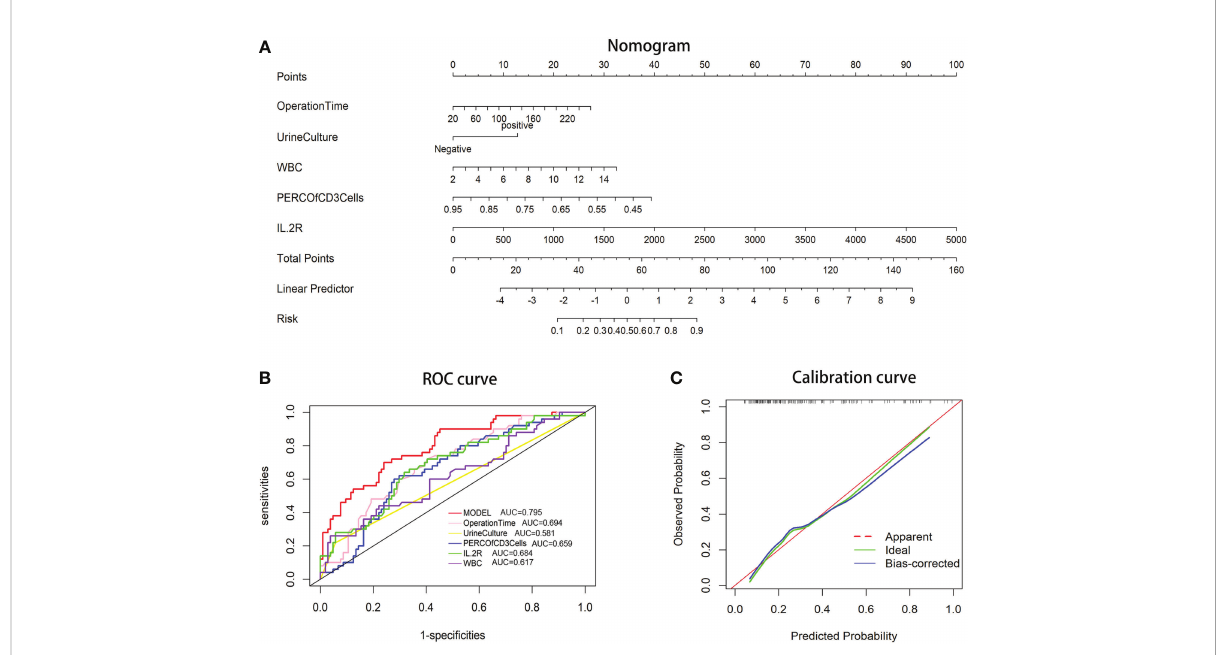
FIGURE 1 (A) Nomogram for patients predicting post-PCNL SIRS. Urine culture, operation time, percentage of CD3 + cells, IL-2R, and WBC count are marked as “ points. ” Total points by adding the four points can predict SIRS rate. (B) Receiver operating characteristic (ROC) curve. The area under curve (AUC) for the model is 0.795, which showed a favorable ability of discrimination. (C) Calibration curve. Calibration curve shows good fi tting of